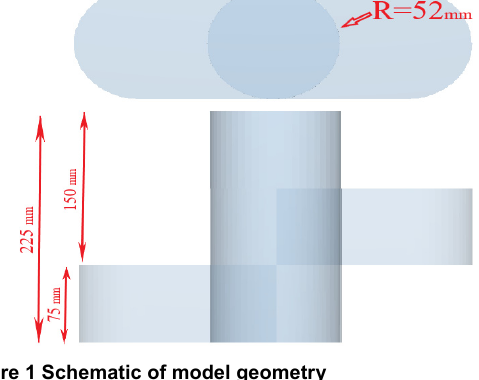
Figure 1 Schematic of model geometry